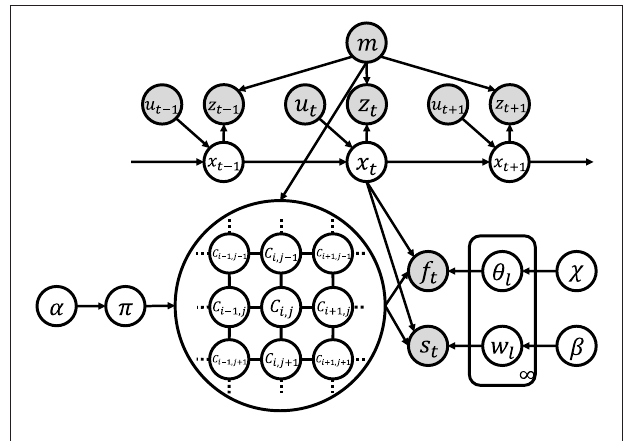
FIGURE 3 | Graphical model of SpCoMapping. Gray nodes indicate observation variables and white nodes are unobserved variables.